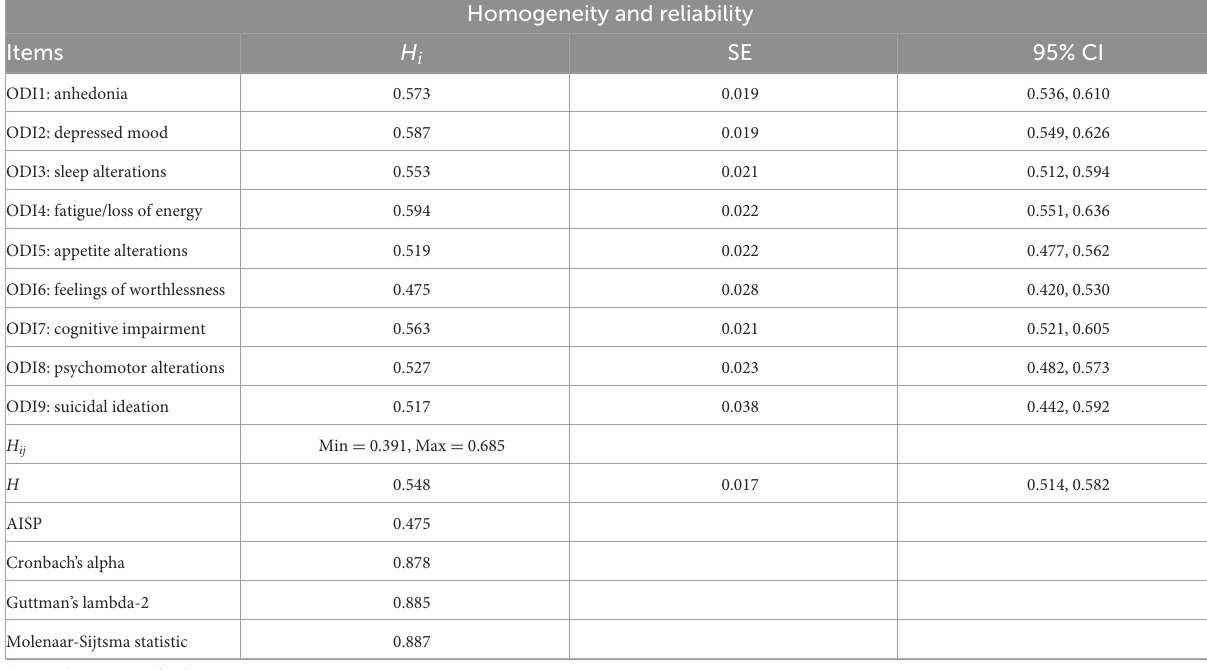
TABLE 3 Homogeneity and reliability analyses of the Occupational Depression Inventory. Homogeneity and